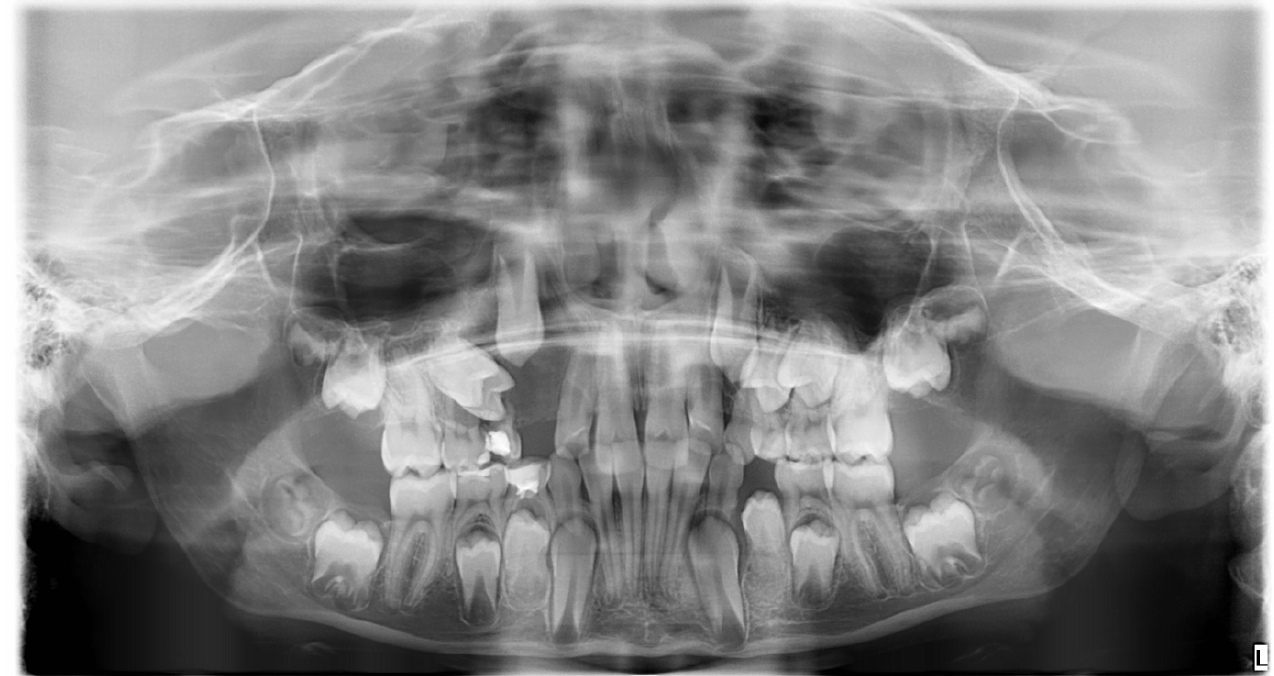
Appl. Sci. 2022 , 12 , x FOR PEER REVIEW Figure 8. CBCT 6 months after surgery—sagittal view. Figure 8. CBCT 6 months after surgery—sagittal view.